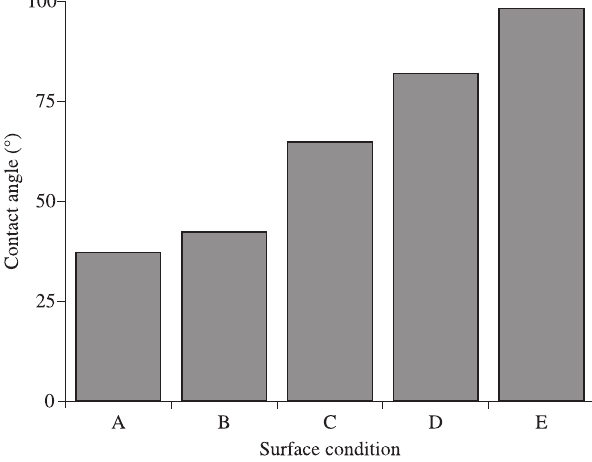
Figure 2. Contact angle of glass slides under different surface conditions. In A, the sample was coated by PECVD of heparin/isopropanol solution with an applied rf power of 15 W. In B, the glass was sonicated in detergent and water baths. Condition C refers to glass surfaces coated by PECVD of heparin/ isopropanol at an rf power of 25 W; in D, the slide was exposed to SF in E the slide was coated by the PECVD of heparin/HMDSO